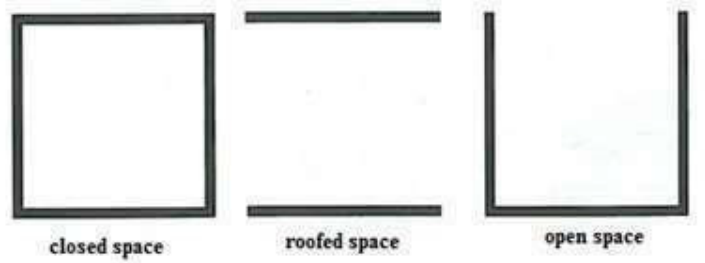
Fig. 1: Horizontal section diagram of various types of spaces (Haeri,